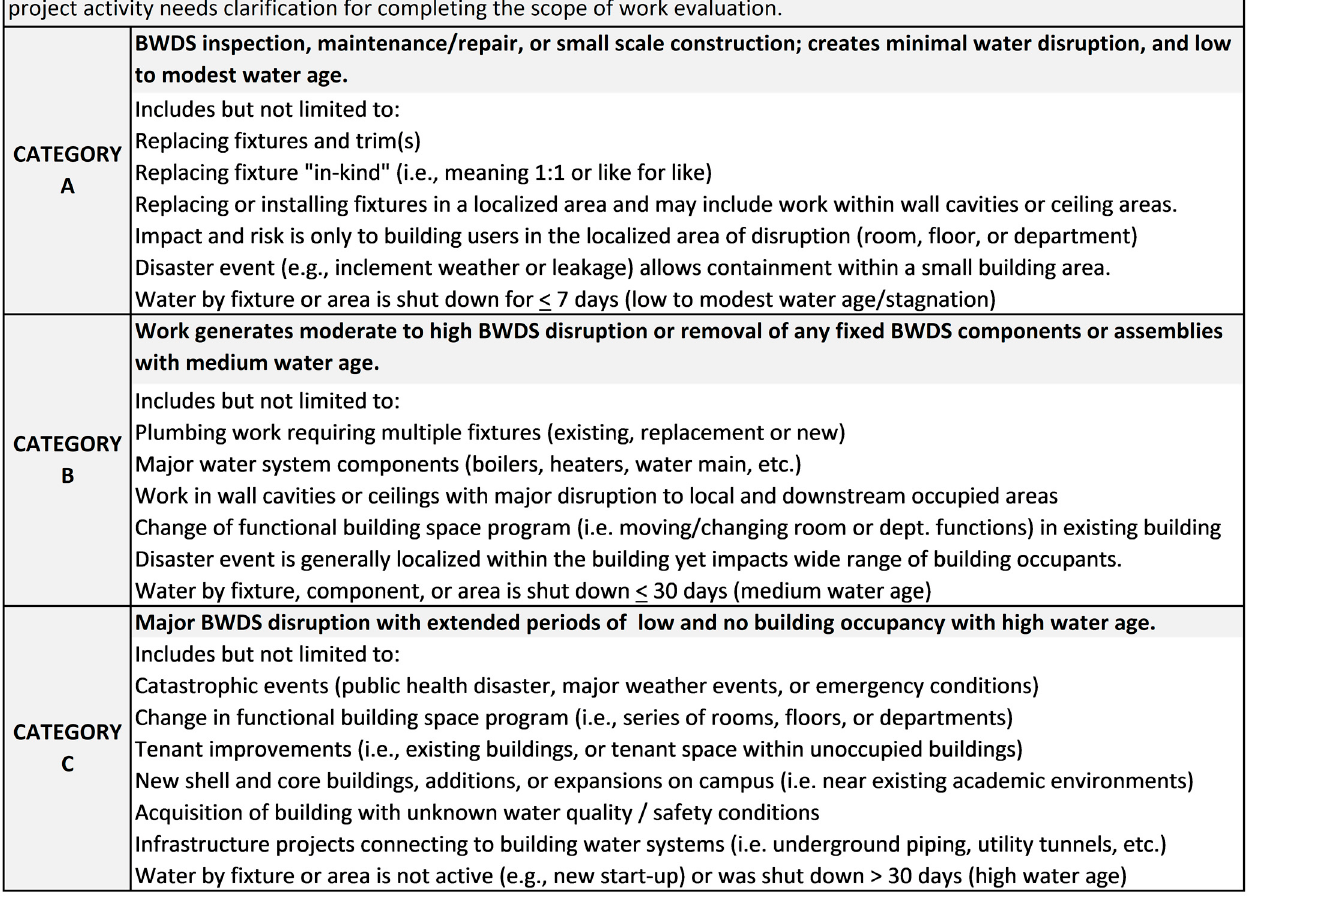
Figure 4. WQSRA water-disruptive event categories. Adapted with permission from Ref. [50]. 2022, Scanlon et al. (CC BY 4.0).